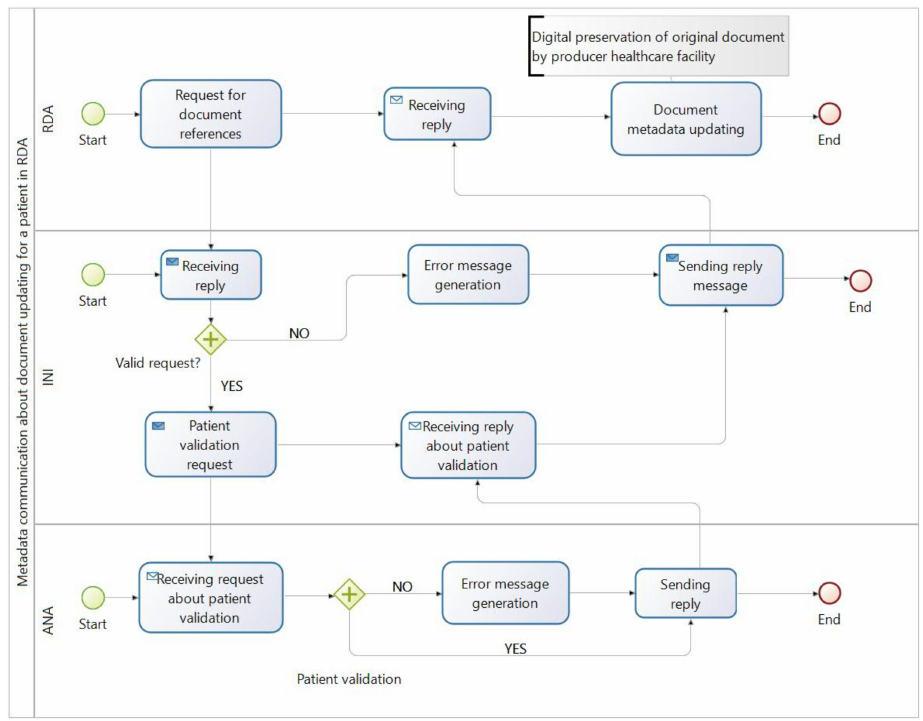
Figure 3. Metadata communication about document updating for a patient in the RDA.